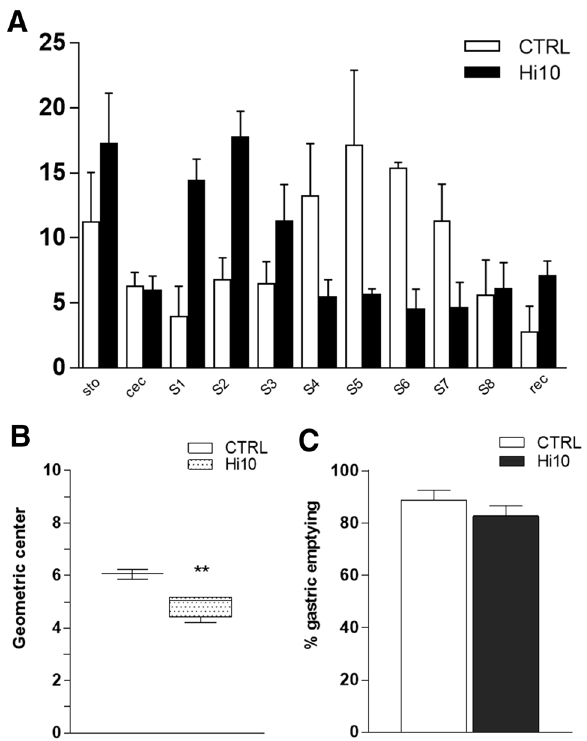
Figure 3. Hermetia illucens meal influences the efficiency of the gastrointestinal transit in gilthead sea bream. ( A ) Percentage of non-absorbable FITC-dextran 250 kDa distribution along the gastrointestinal tract consisting of stomach (sto), pyloric caeca (cec), proximal intestine (S1–S3), median intestine (S4-S6), distal intestine (S7-S8) and rectum (rec). ( B ) Geometric center of non-absorbable FITC-dextran distribution. ( C ) Percentage of gastric emptying in the different experimental groups. Data are reported as mean ± SEM for panels ( A ) and ( C ) and as median, minimum, maximum, upper and lower quartiles for panel ( B ). ** P < 0.01 versus CTRL by unpaired Student’s t test. n = 5 fish/experimental